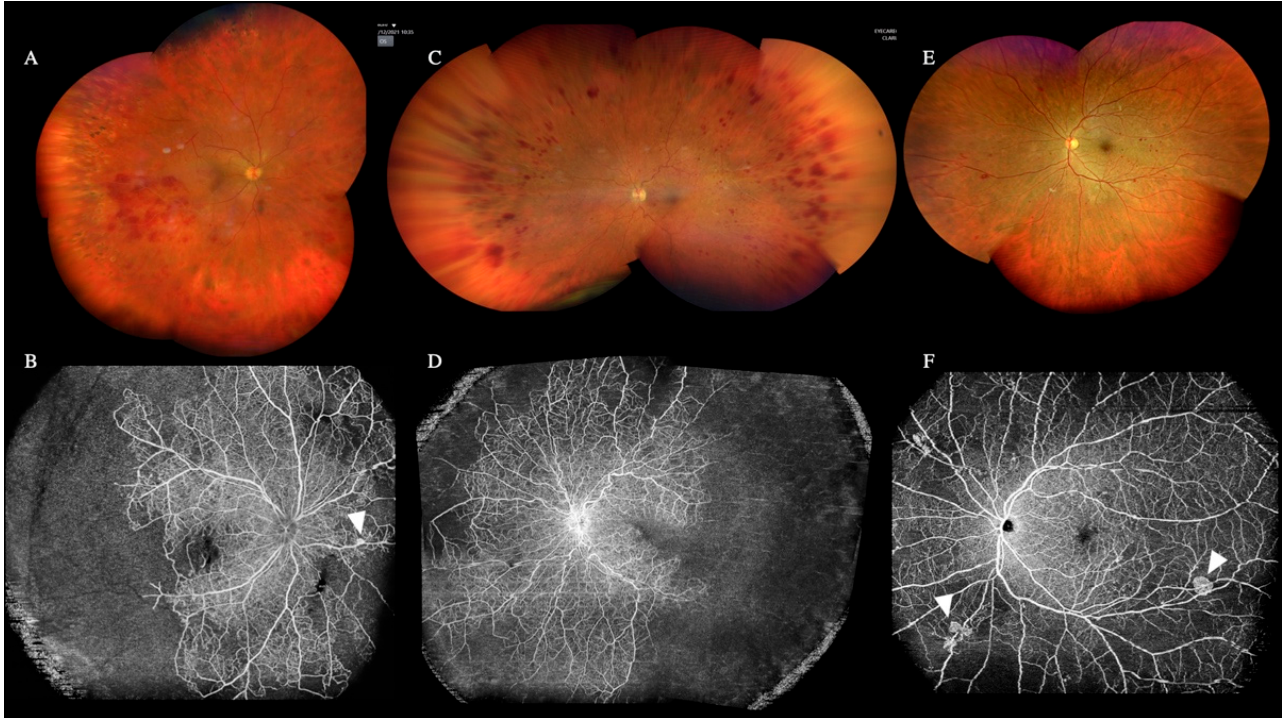
Figure 8. Ultra-wide-field (UWF) color fundus retinography ( A , C , E ), wide-field optical coherence tomography angiography (WF-OCTA) ( B , F ), and UWF-OCTA created with the mosaic software ( D ). ( A , C ) show two cases of central retinal vein occlusion (CRVO). The WF-OCTA images ( B , D ) revealed peripheral retinal ischemia with a nasal neovascularization bud in ( B ) (arrowheads) and without neovascularization in ( D ). ( E ) shows an eye with diabetic retinopathy and the corresponding WF-OCTA ( F ) manifested mild peripheral ischemia and neovascularization elsewhere (NVE) (arrowheads).